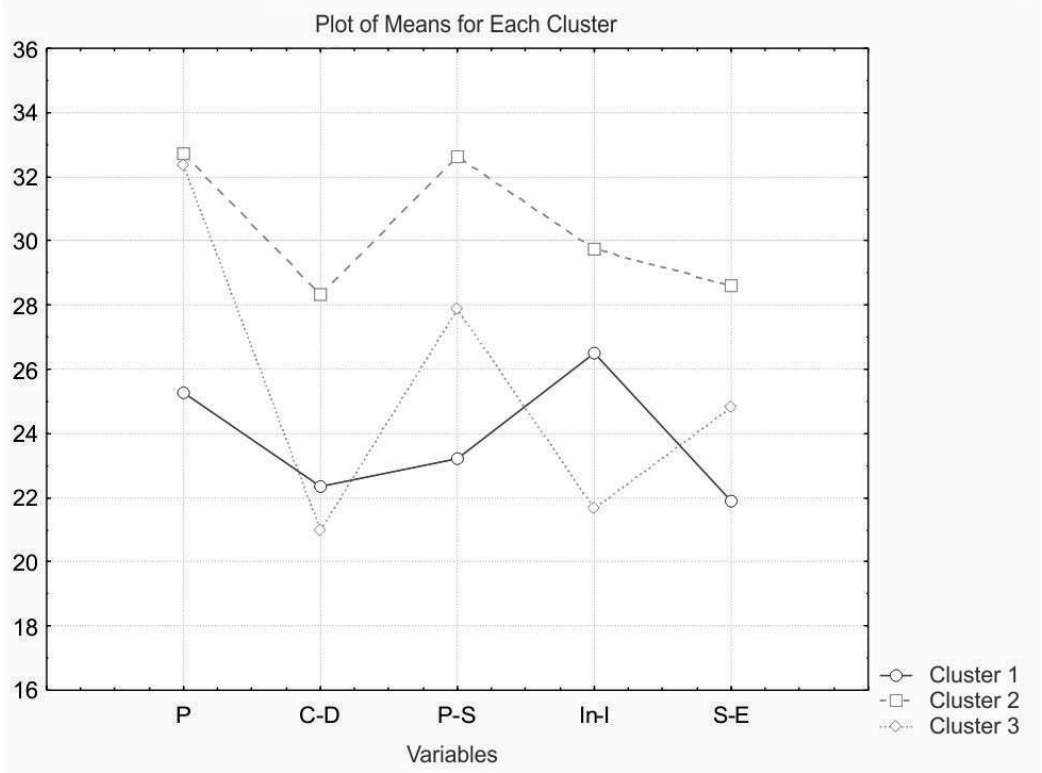
Fig.1. Graphs of mean indices for each